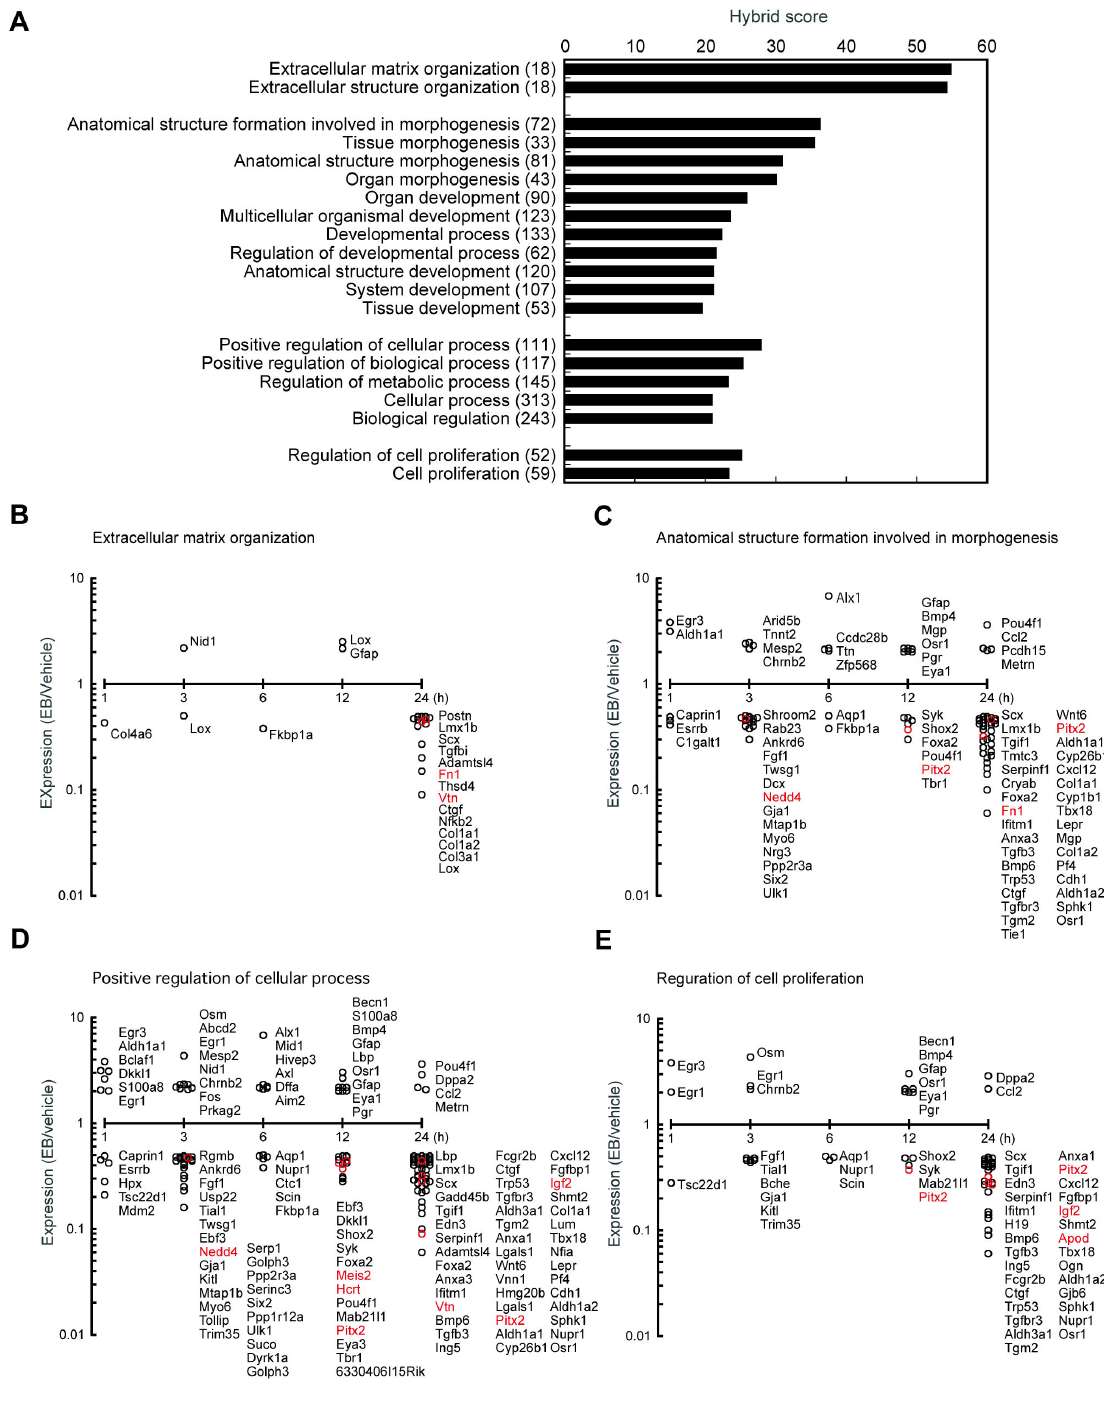
Figure 2. Gene ontology enrichment analysis for the genes differentially expressed between EB- and vehicle-treated neonatal mouse hypothalamus. The whole hypothalamus was collected from neonatal female mice 1, 3, 6, 12, and 24 h after EB or vehicle injection. The 478 unique Entrez Gene IDs were analyzed by a biological process gene ontology analysis. Significant regulated 20 gene ontology terms were shown in A. Time-dependent changes in gene expressions were depicted for 4 representative gene ontology terms such as the extracellular matrix organization (B), anatomical structure formation involved in morphogenesis (C), positive regulation of cellular process (D), and regulation of cell proliferation (E). Gene symbols in red were selected for further investigation to evaluate sex difference in expression levels by a semiquantitative RT-PCR. doi: 10.1371/journal.pone.0079437.g002 PLOS ONE |